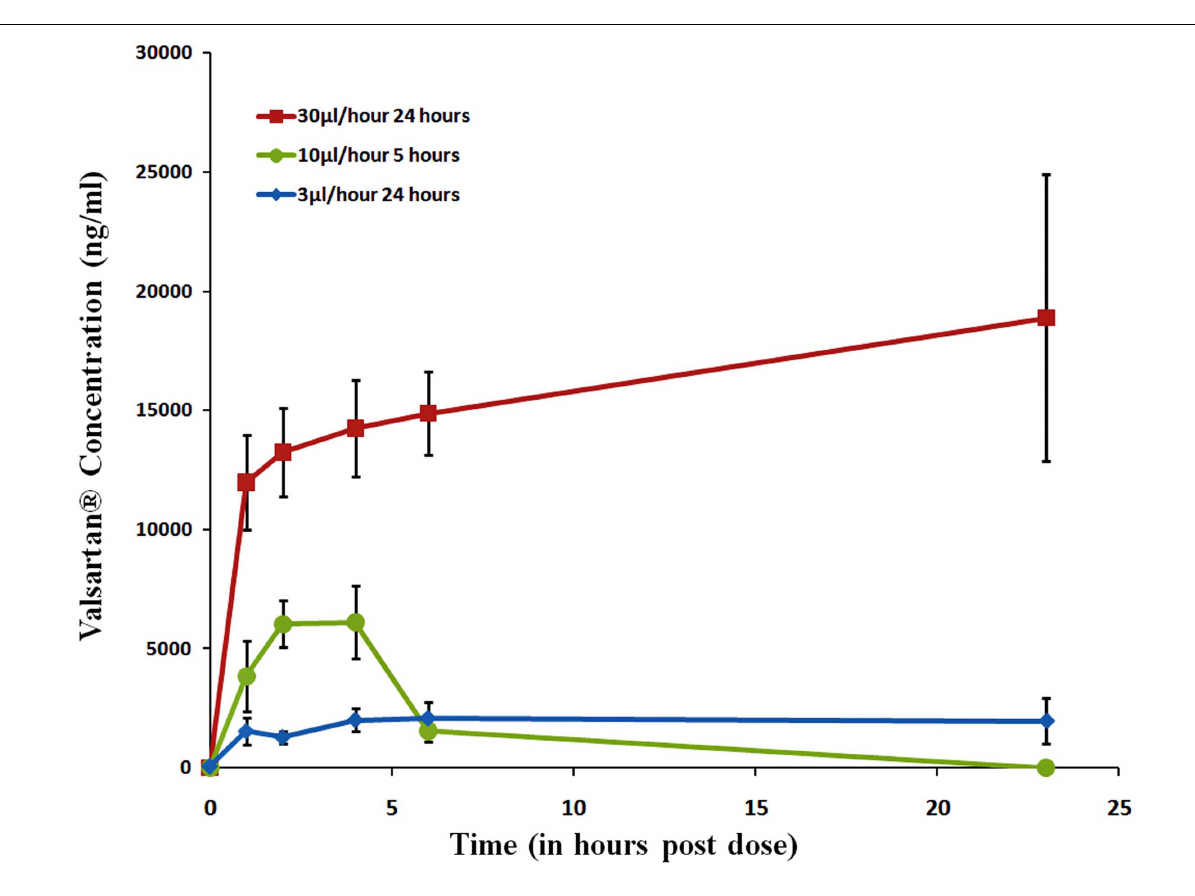
FIGURE 11 | Valsartan ® plasma exposure for the three